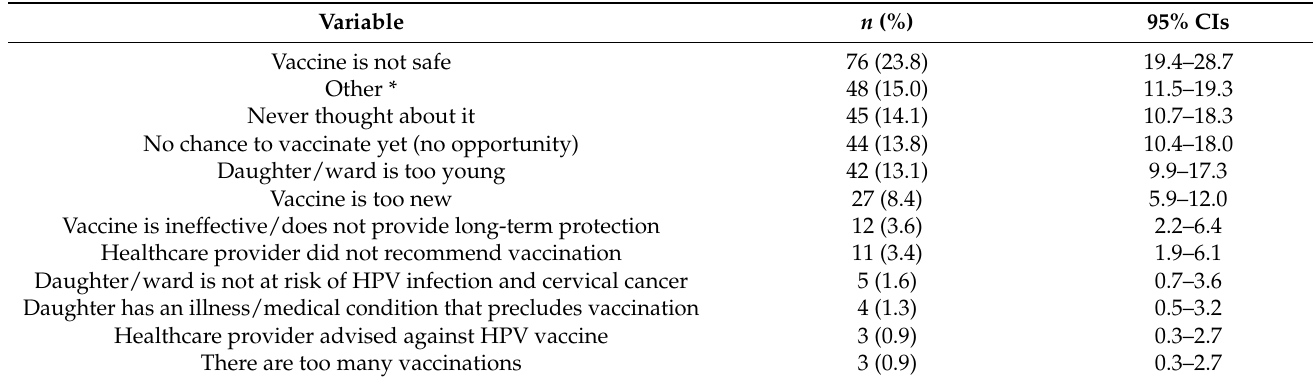
Table 1. Frequency distribution of caregivers’ reasons for being unsure or not wanting to vaccinate before coding of “other” free text reasons ( n =